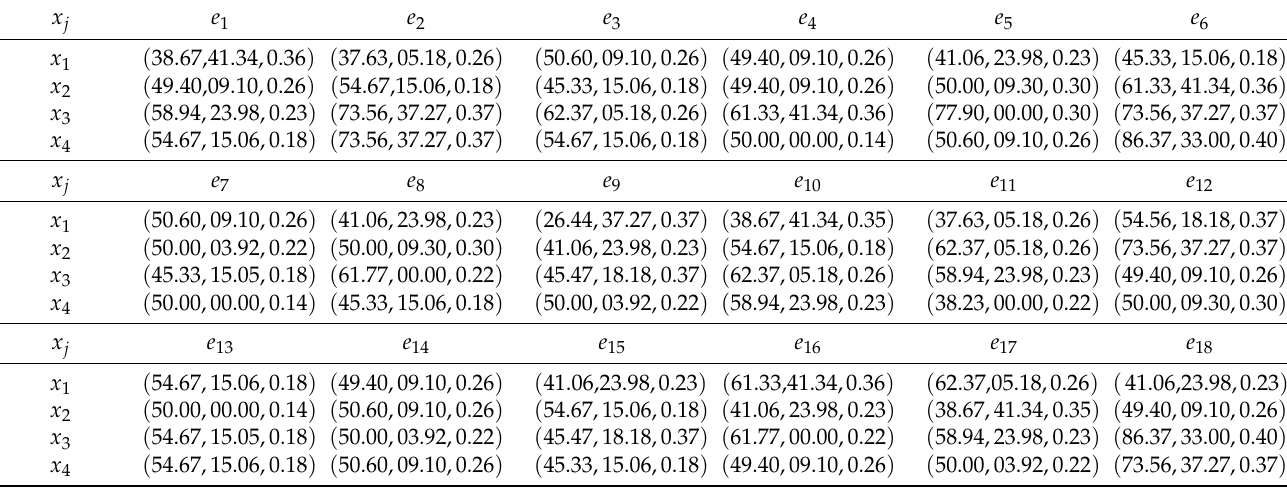
Table 5. Comprehensive cloud in the first